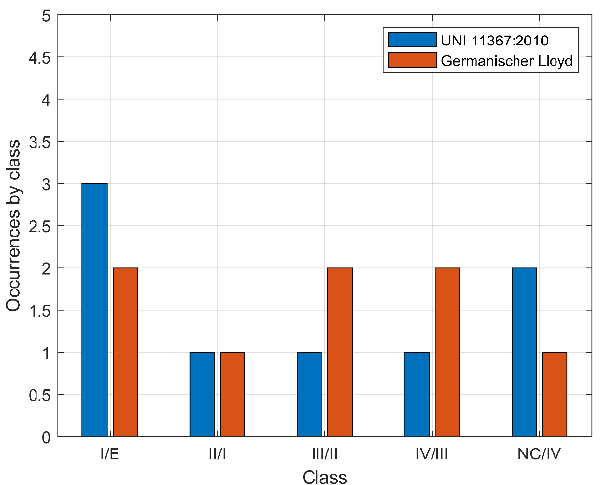
Figure 6. Occurrences by class for the standardized level difference.